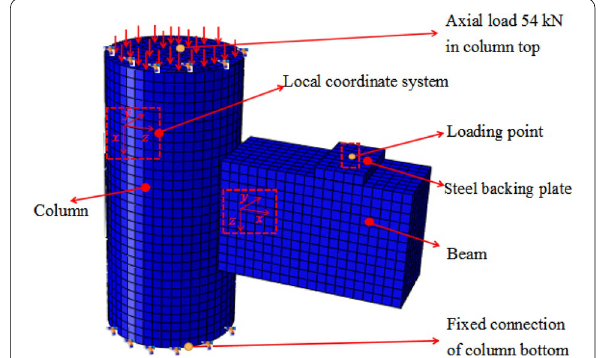
Fig. 21 Mesh generations, boundary and loading conditions of